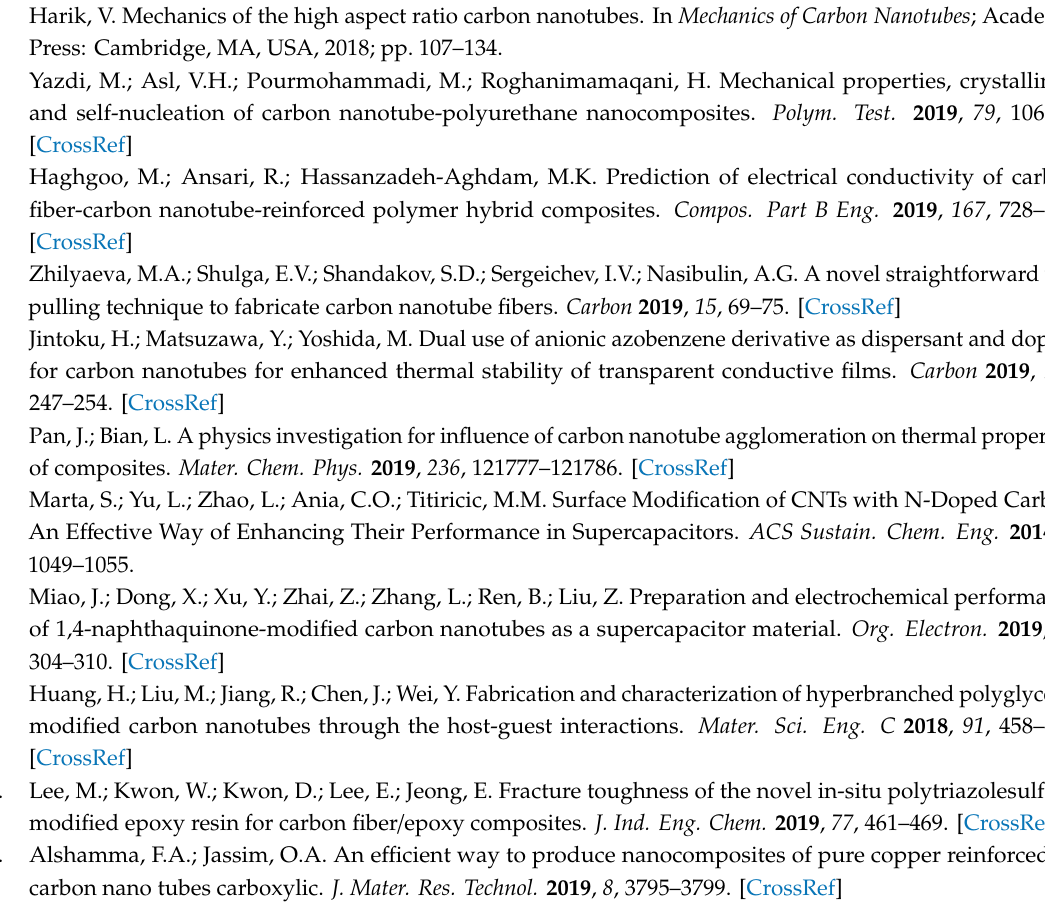
Figure S1: Scheme of the device used for photoinduced frontal polymerization; Figure S2: TGA curves of pure epoxy resin; Figure S3: The temporal distribution of temperature of the unmodified MWCNTs / epoxy and PABA-modified MWCNTs / epoxy reaction system with di ff erent filler